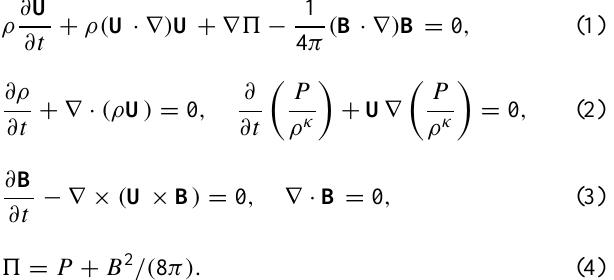
Fig. 2. Nonsteady profiles of plasma density, magnetic field strength, plasma pressure and magnetic pressure along the subso- lar